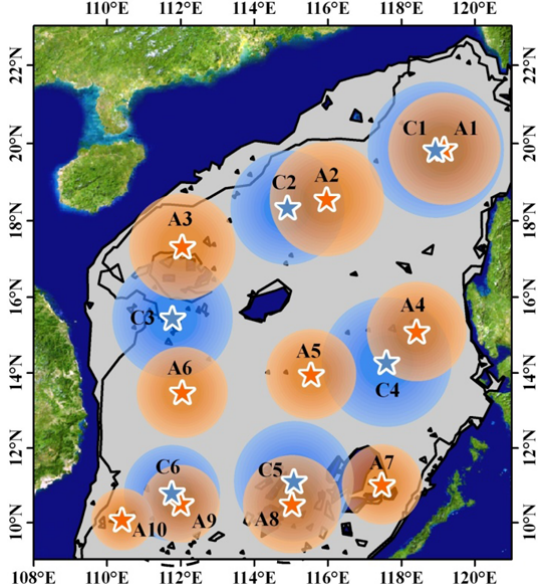
Fig. 7. Centroids and spatial domains of cyclonic and anticyclonic eddies. Centroids of AEs and CEs are shown by stars of different colors. The circles in different colors represent the spatial dimen- sion of each cluster, and the radius is defined by the mean distance from these eddies’ generation locations to corresponding